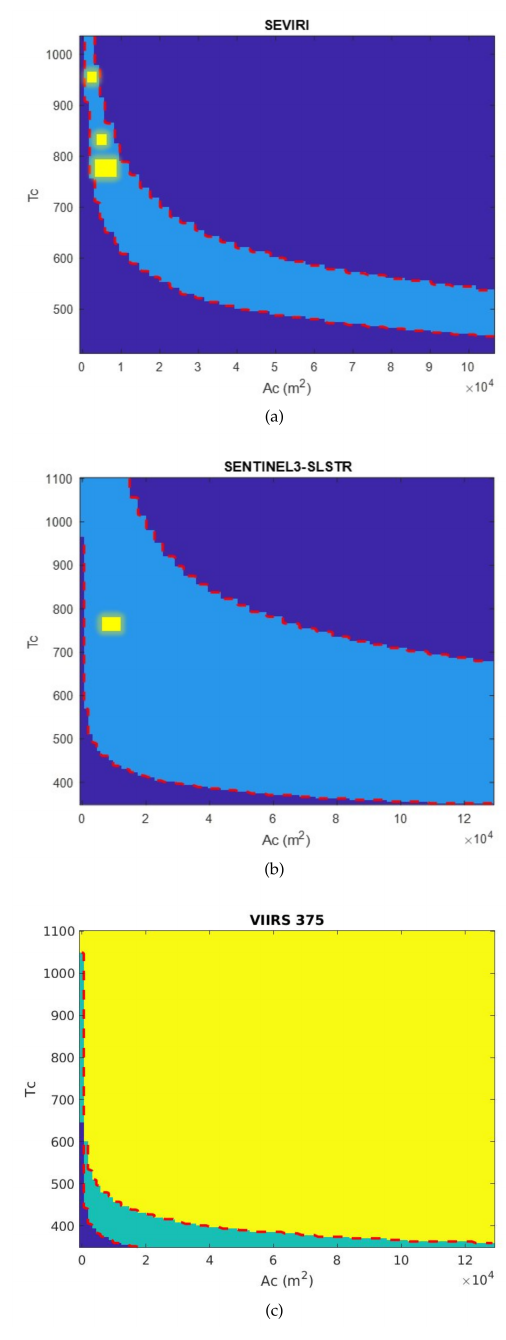
Figure 3. Retrieved regions [ Ac , Tc ] for each remote sensor : ( a ) SEVIRI; ( b ) SENTINEL-3 SLSTR; ( c )